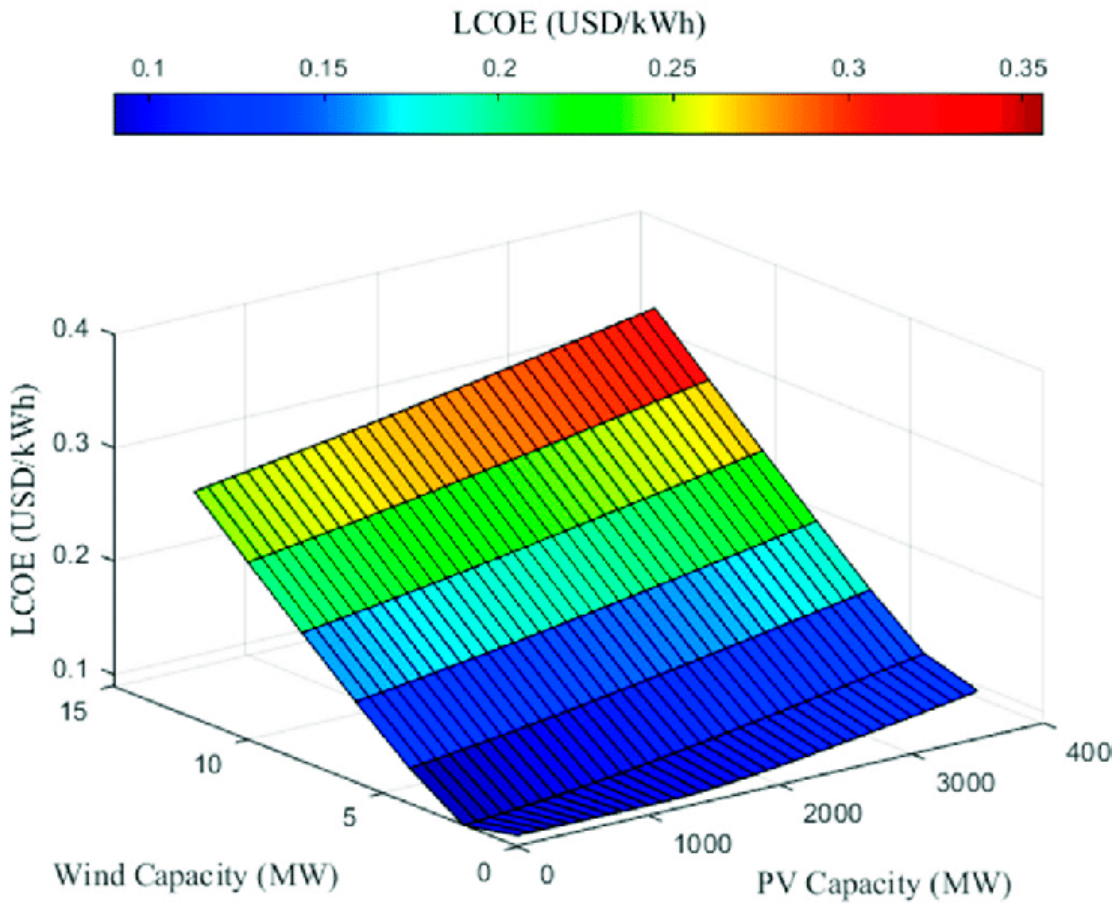
Figure 7. Levelized cost of PV–wind hybrids in Zimbabwe [19].